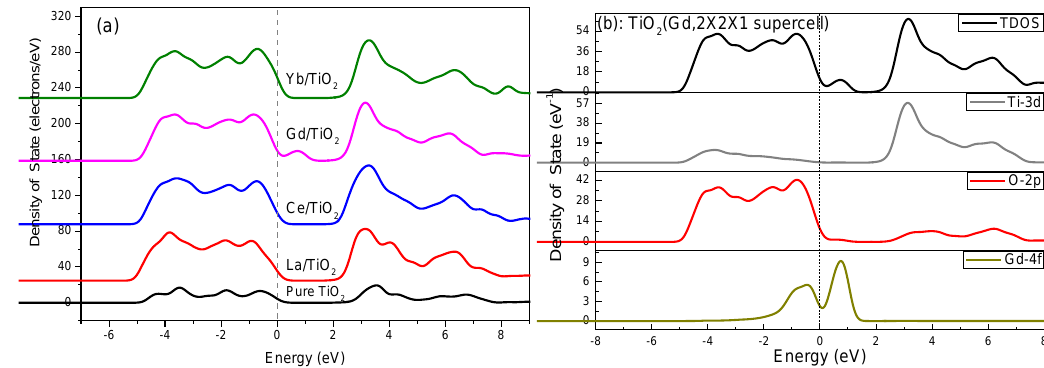
Figure 6. TDOS of RE/TiO 2 (2 × 2 × 1 supercell) ( a ) and PDOS ( b ) of Gd/TiO 2 (2 × 2 × 1 supercell).